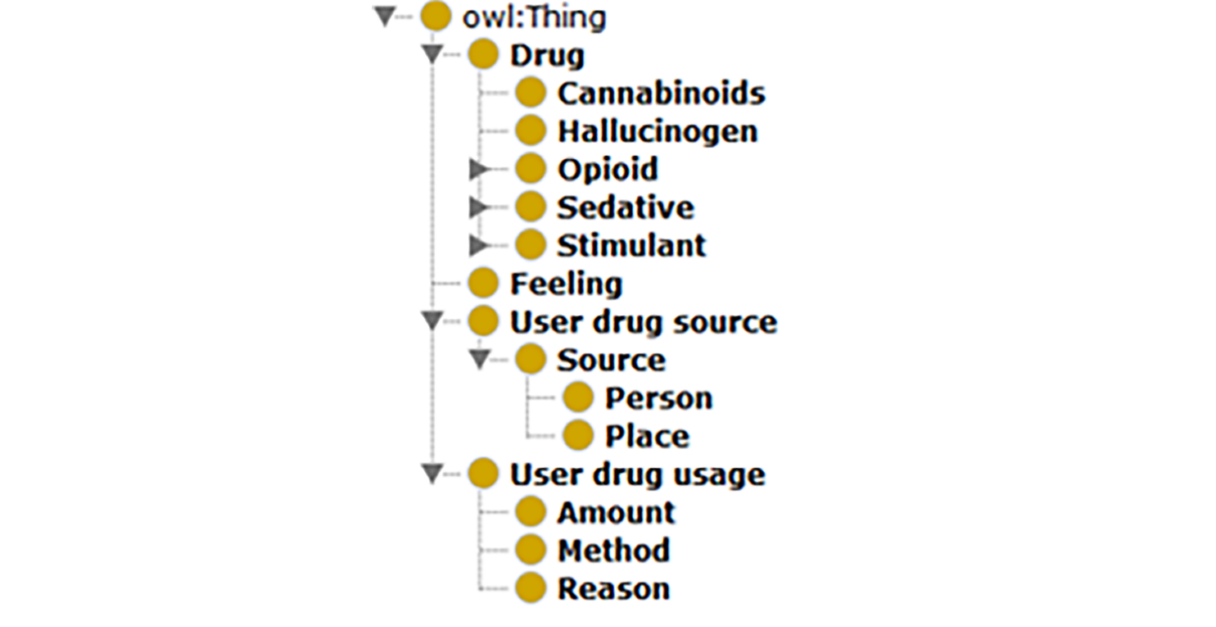
Figure 2. Drug abuse ontology for drug main terms and